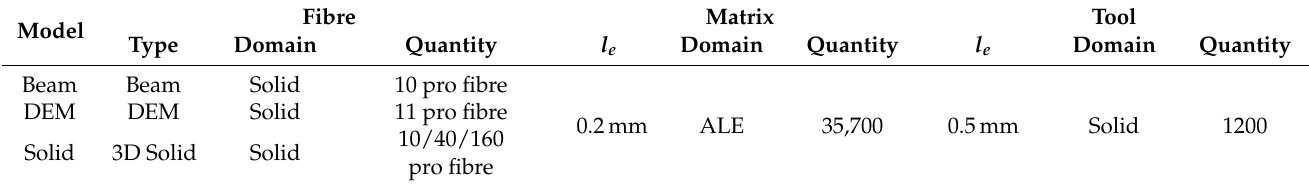
Table 5. Numerical parameters of the three different discretisation methods for the collision